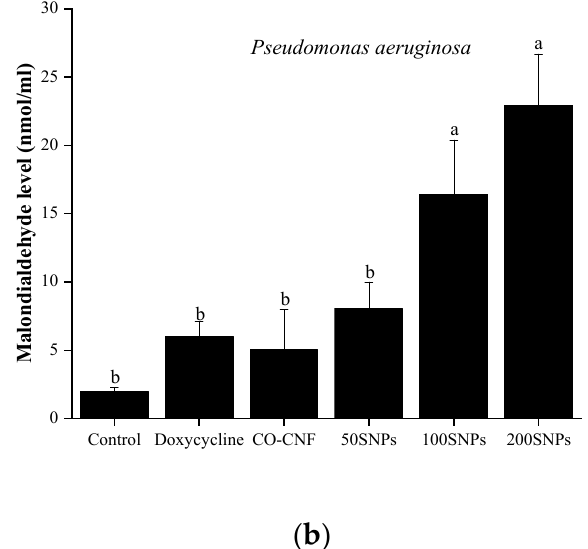
Figure 5. Effects of nanoparticles on the malondialdehyde level of ( a ) Fusobacterium nucleatum and ( b ) Pseudomonas aeruginosa . Data are expressed as mean ± S.D. ( n = 3). The values with different letters (a–b) represent significantly different ( p < 0.05) as analyzed by Tukey’s test. CO-CNF: κ -carrageenan oligosaccharides linked cellulose nanofibers; 50SNPs: 50 mg surfactin-loaded CO-CNF nanoparticles; 100SNPs: 100 mg surfactin-loaded CO-CNF nanoparticles; 200SNPs: 200 mg surfactin-loaded CO-CNF nanoparticles.